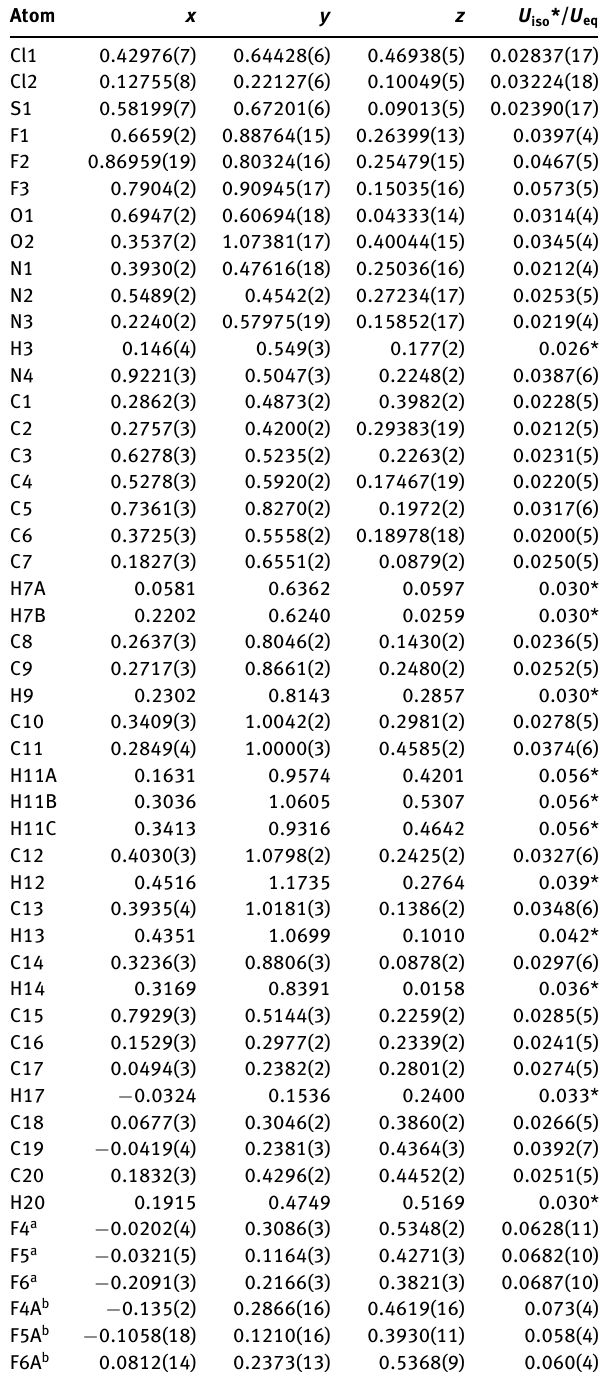
Table 2: Fractional atomic coordinates and isotropic or equivalent isotropic displacement parameters (Å 2